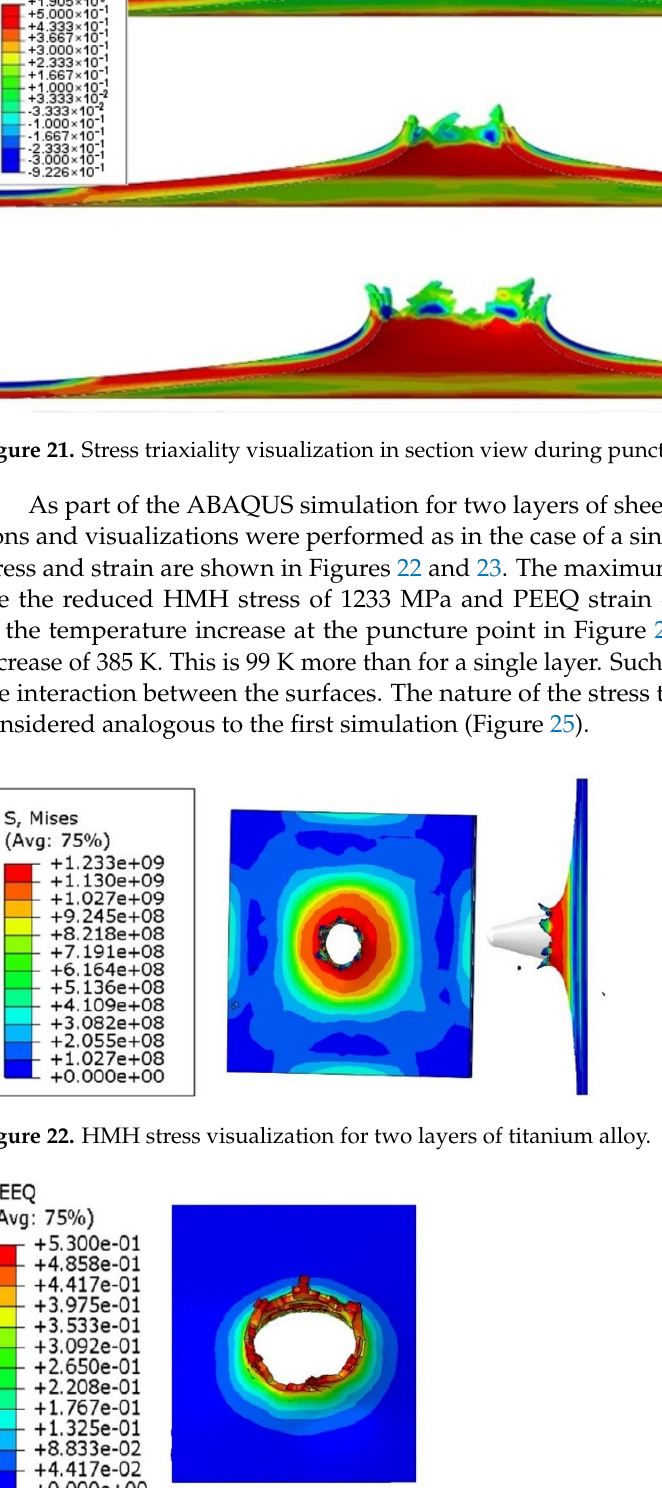
Figure 20. Temperature increase visualization due to the puncture of the titanium alloy sheet by the striker—section view.